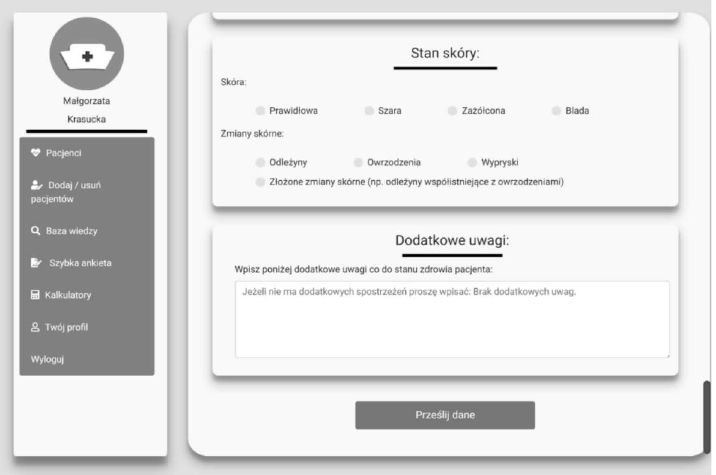
Figure 8. Appearance of the module for the description of a geriatric patient under long-term home care – part 2